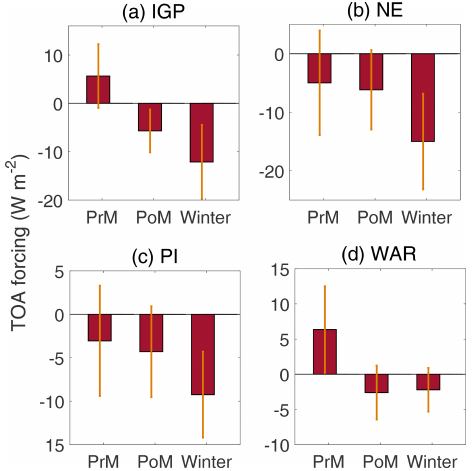
Figure 11. The climatological seasonal variation of aerosol radia- tive forcing at TOA estimated using assimilated aerosol products and averaged over four subregions: (a) IGP, (b) NE, (c) PI and (d)